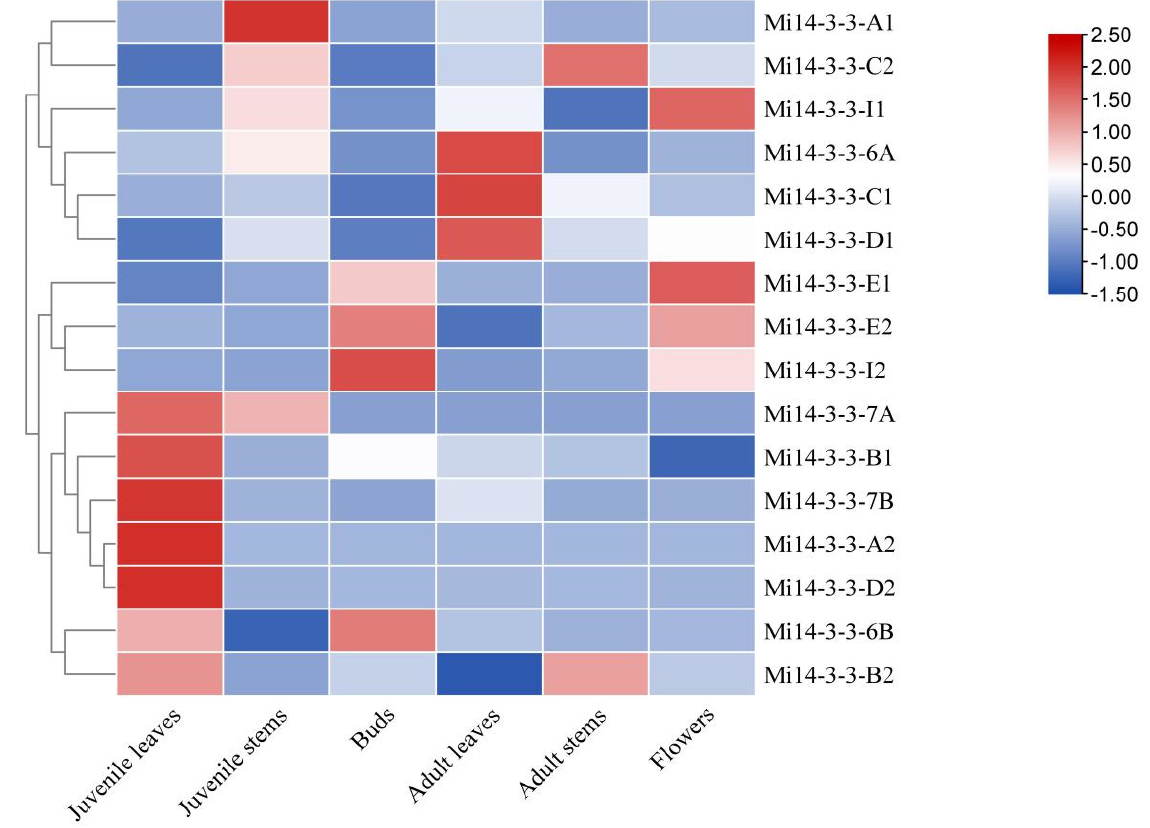
Figure 8. Expression analysis of Mi14-3-3s in different tissues and organs of mango plants. Shown is a heatmap generated by TBtools showing a cluster map of the Mi14-3-3 genes in different tissues. The colour gradient (red/white/blue) indicates the gene expression level (from high to low ).